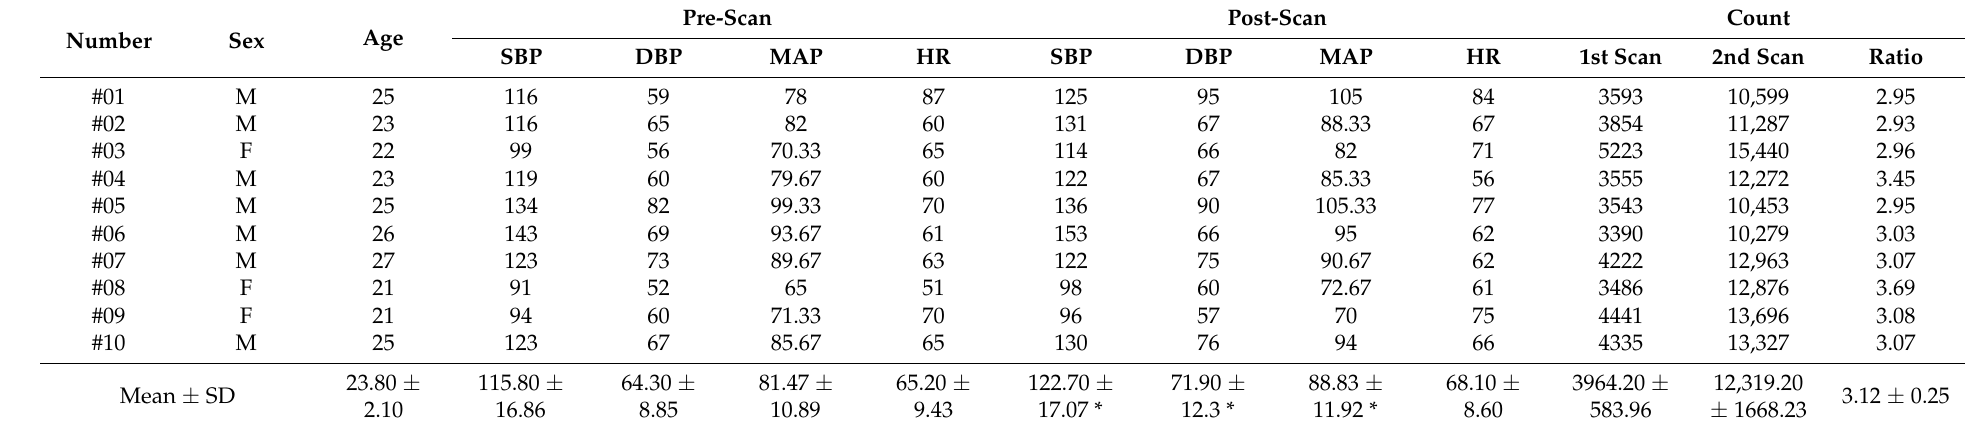
Table 1. Demographic information (N =